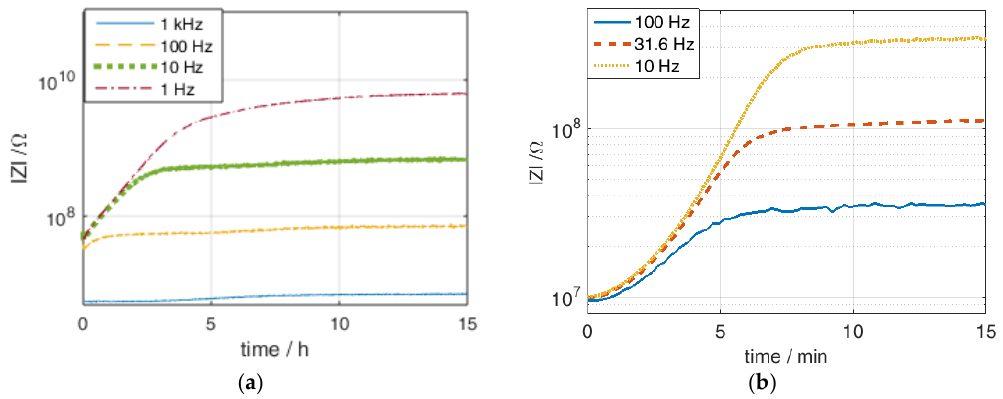
Figure 4. Absolute value of the impedance during curing. The measurement is started directly after applying the adhesive. ( a ) slow curing two-component epoxy; ( b ) fast curing two-component